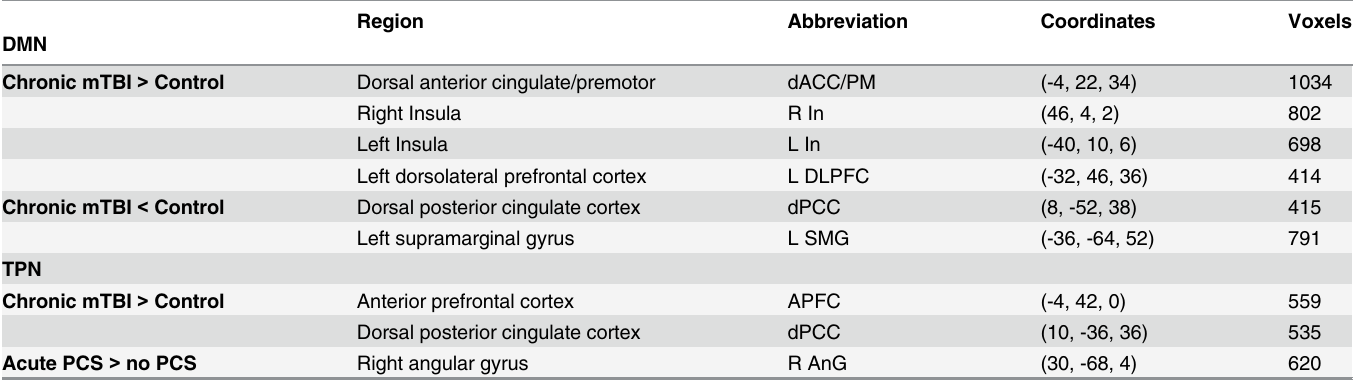
Table 2. Voxel wise Group